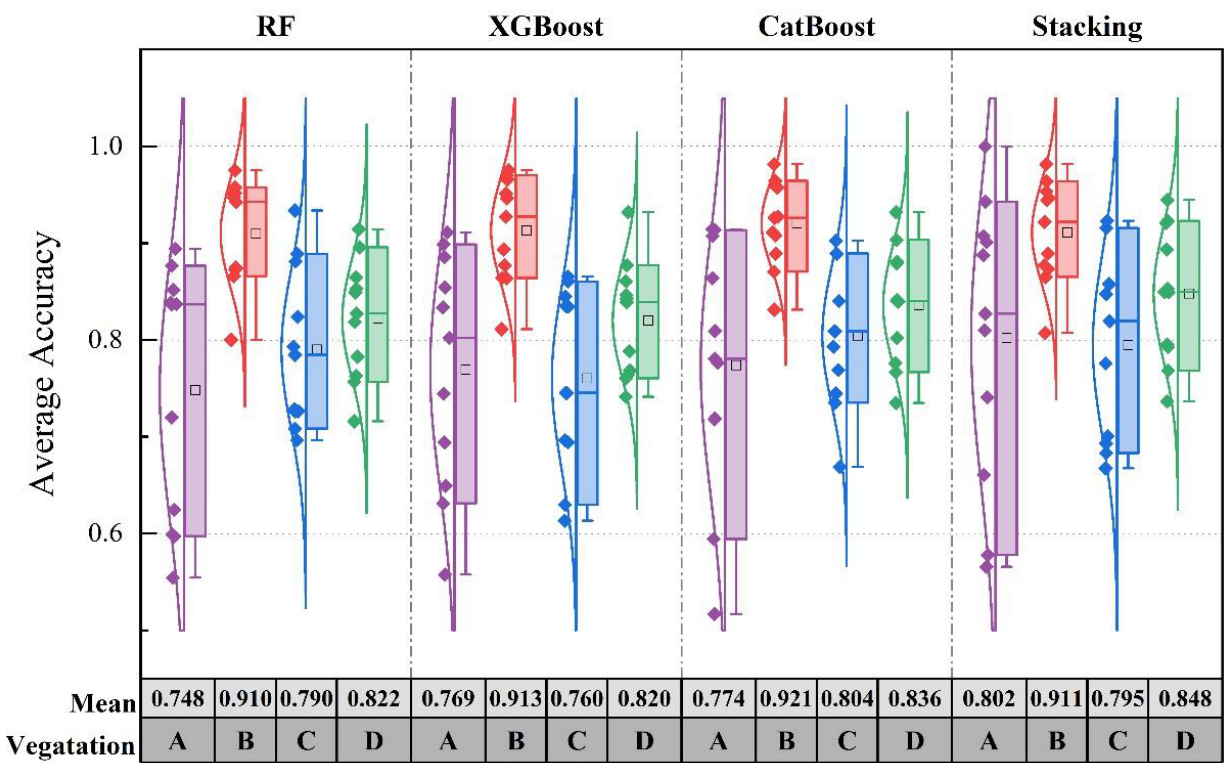
Figure 8. Distribution of the average accuracy of each vegetation type using four classification models with all schemes. A, shrub; B, forest; C, deep-water marsh vegetation; D, shallow-water marsh vegetation.